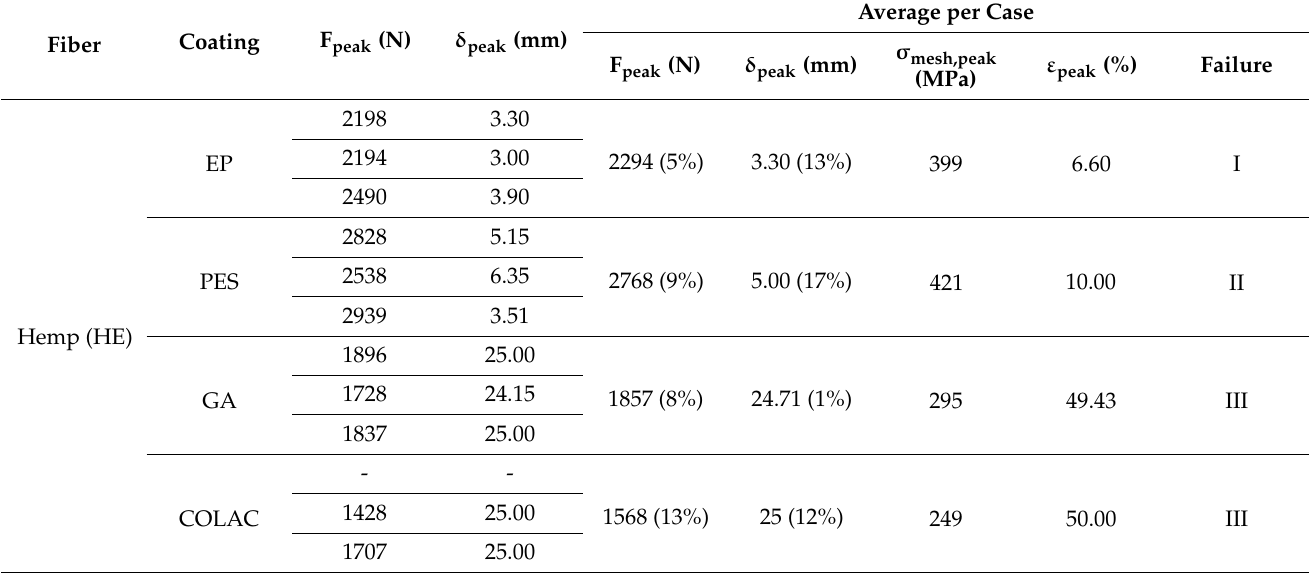
Table 10. Hemp FRCM’s tensile test